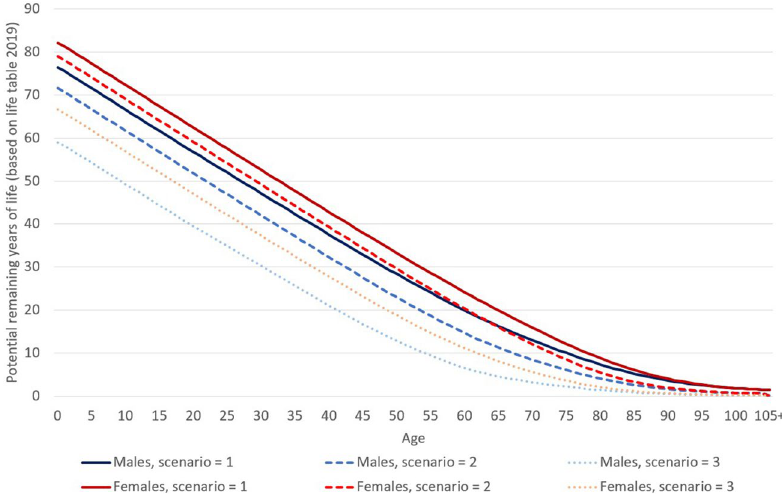
Figure 1. Potential years of remaining life (Eq. 1) according to age used in the three scenarios of the analysis for males and females based on the life tables for the year 2019. Source: author’s calculation according to Eq. (1) 15